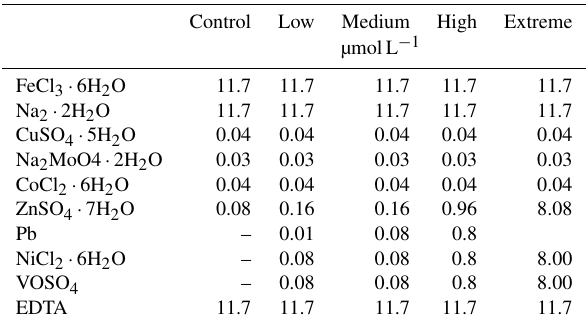
Table 1. Trace metal concentrations in the growth medium of the different